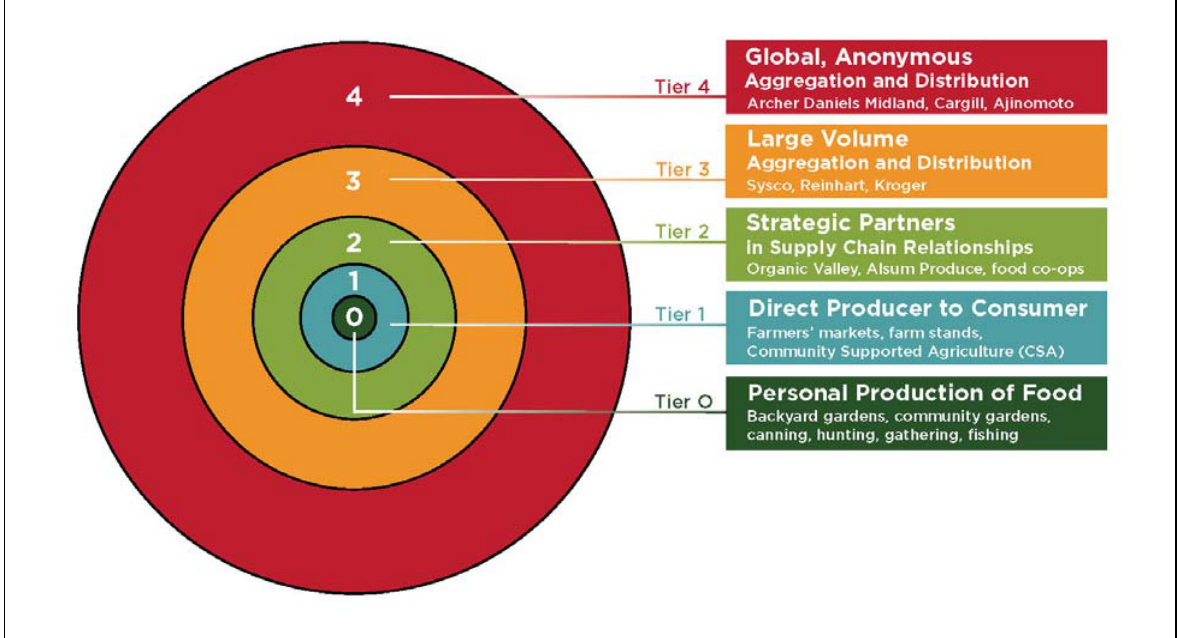
Image courtesy of University of Wisconsin–Madison Center for Integrated Agricultural